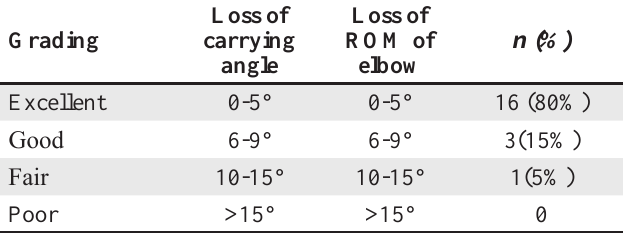
Table 2 : Patients grading according to Flynn